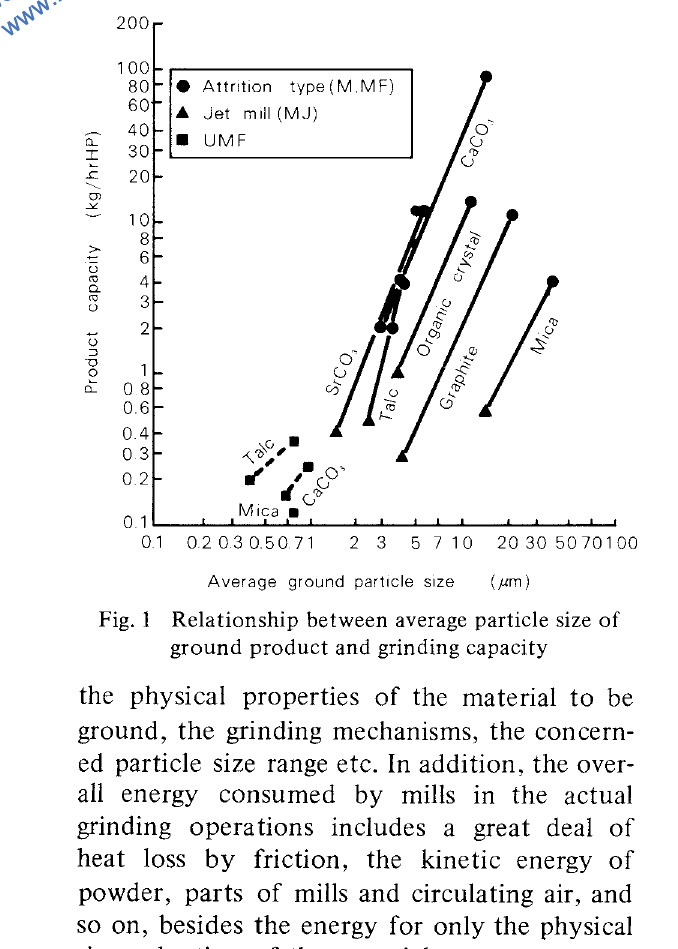
Fig. 1 Relationship between average particle size of ground product and grinding capacity